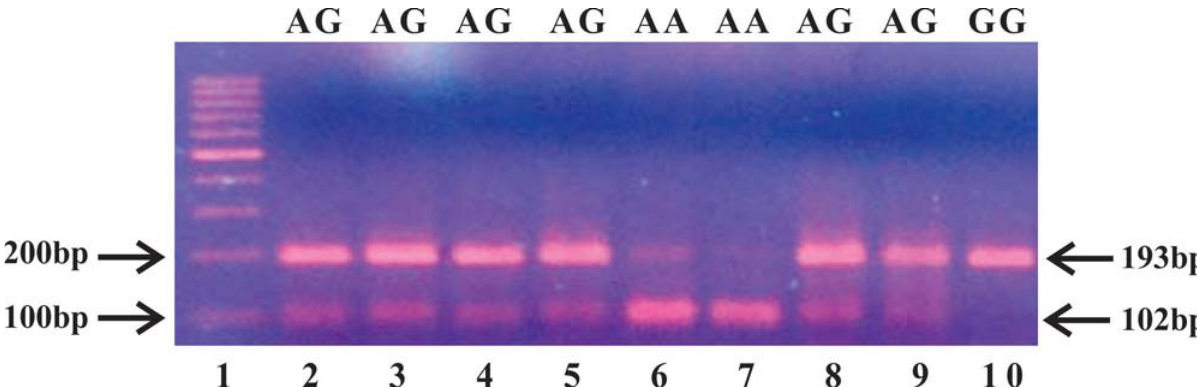
Figure 1- PCR-RFLP of EGF+61 A>G polymorphism. Agarose gel electrophoresis of EGF DNA fragments stained with ethidium bromide. Lane 1:100bp DNA Ladder; Lanes 2-5, 8 and 9: heterozygous AG; Lanes 6 and 7: homozygous AA; Lane 10: homozygous GG. PCR-RFLP: polymerase chain reaction - restriction fragment length polymorphism; EGF: epidermal growth Table 3- Association between EGF+61 A>G polymorphism and clefts risk